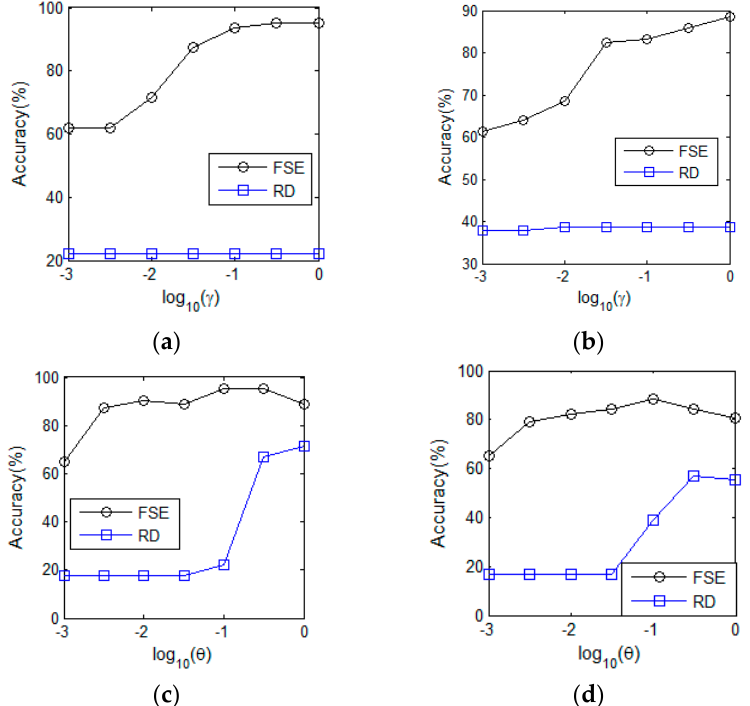
Figure 4. Sensitivity analysis of feature specificity enhancement (FSE) ( Public benchmark.